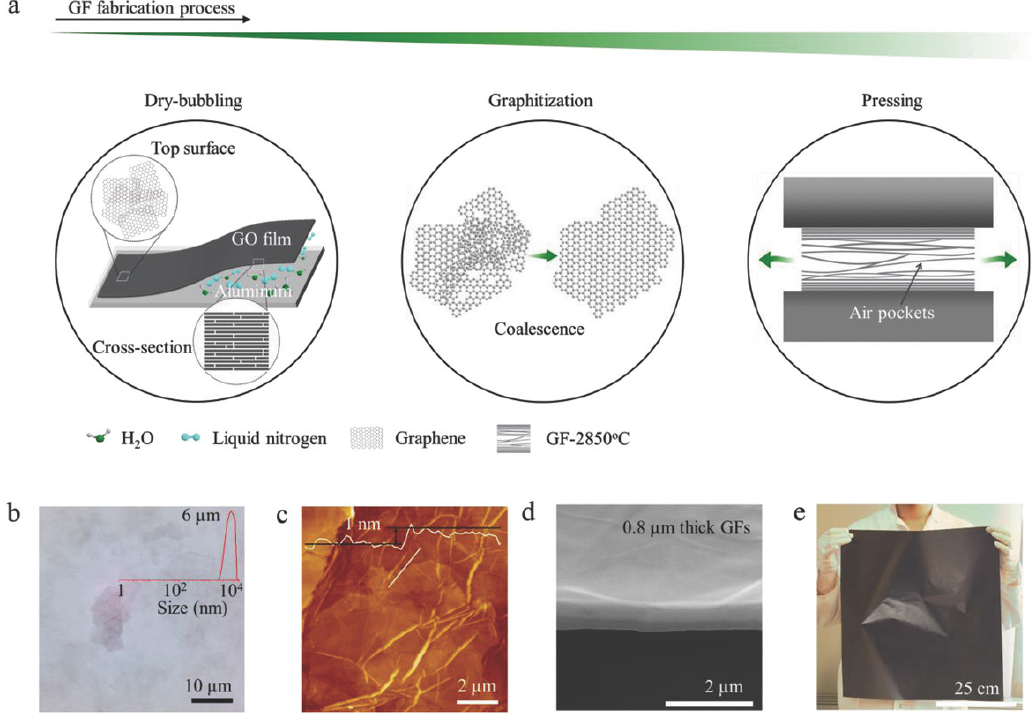
Figure 2. ( a ) Sketch of the fabrication process of GF. ( b ) Optical image of GO flakes with an average size of about 6 μ m. ( c ) AFM image of GO flakes with a thickness of less than 1 nm. ( d ) SEM image of cross-section of the fabricated GFs. ( e ) Optical image of the fabricated large-area GFs. Reprinted with permission from ref. [32] Copyright 2018, Wiley.